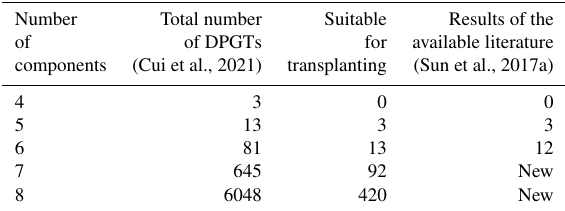
Table 2. Classification of the DPGT. Number of Creation Case Case Case components results